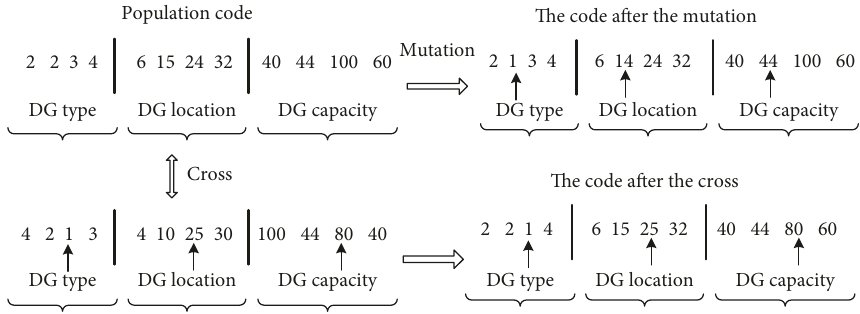
Figure 2: The segmented point cross and mutation.